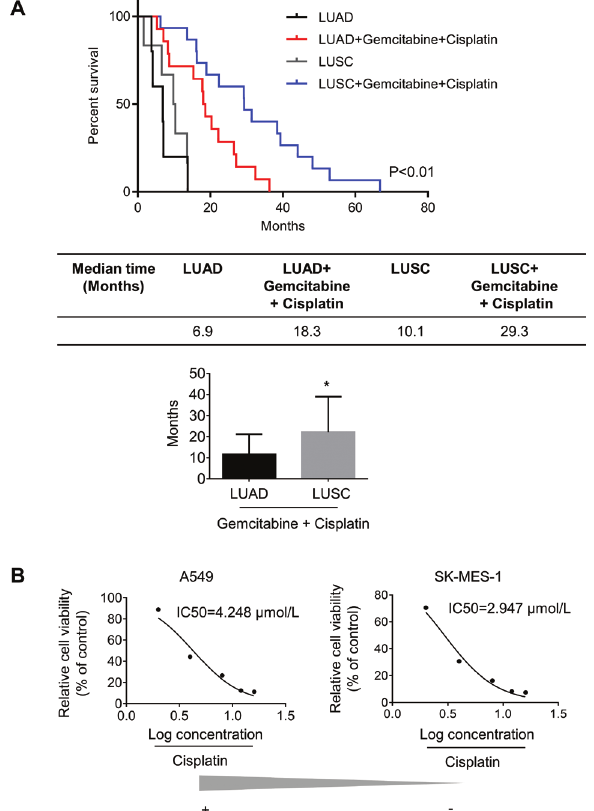
Fig. 1. LUAD was more resistant to chemotherapy than LUSC. A, upper panel, the survival time of LUAD patients was shorter than that of LUSC patients administrated with gemcitabine and cisplatin ( P < 0.01); lower panel, the extended survival of LUAD patients was shorter than that of LUSC patients ( P = 0.04). B, the A549 and SK-MES-1 cell lines with the treatment of cisplatin (2, 4, 8, 12, and 16 μmol/L) were placed into 96-well plates and incubated with fresh medium for 48 h. Cell viability was determined by CCK-8 kit at 450 nm. Data represent mean ± SD of three independent experiments ( P < 0.01). LUAD, lung adenocar- cinoma; LUSC, lung squamous cell carcinoma.